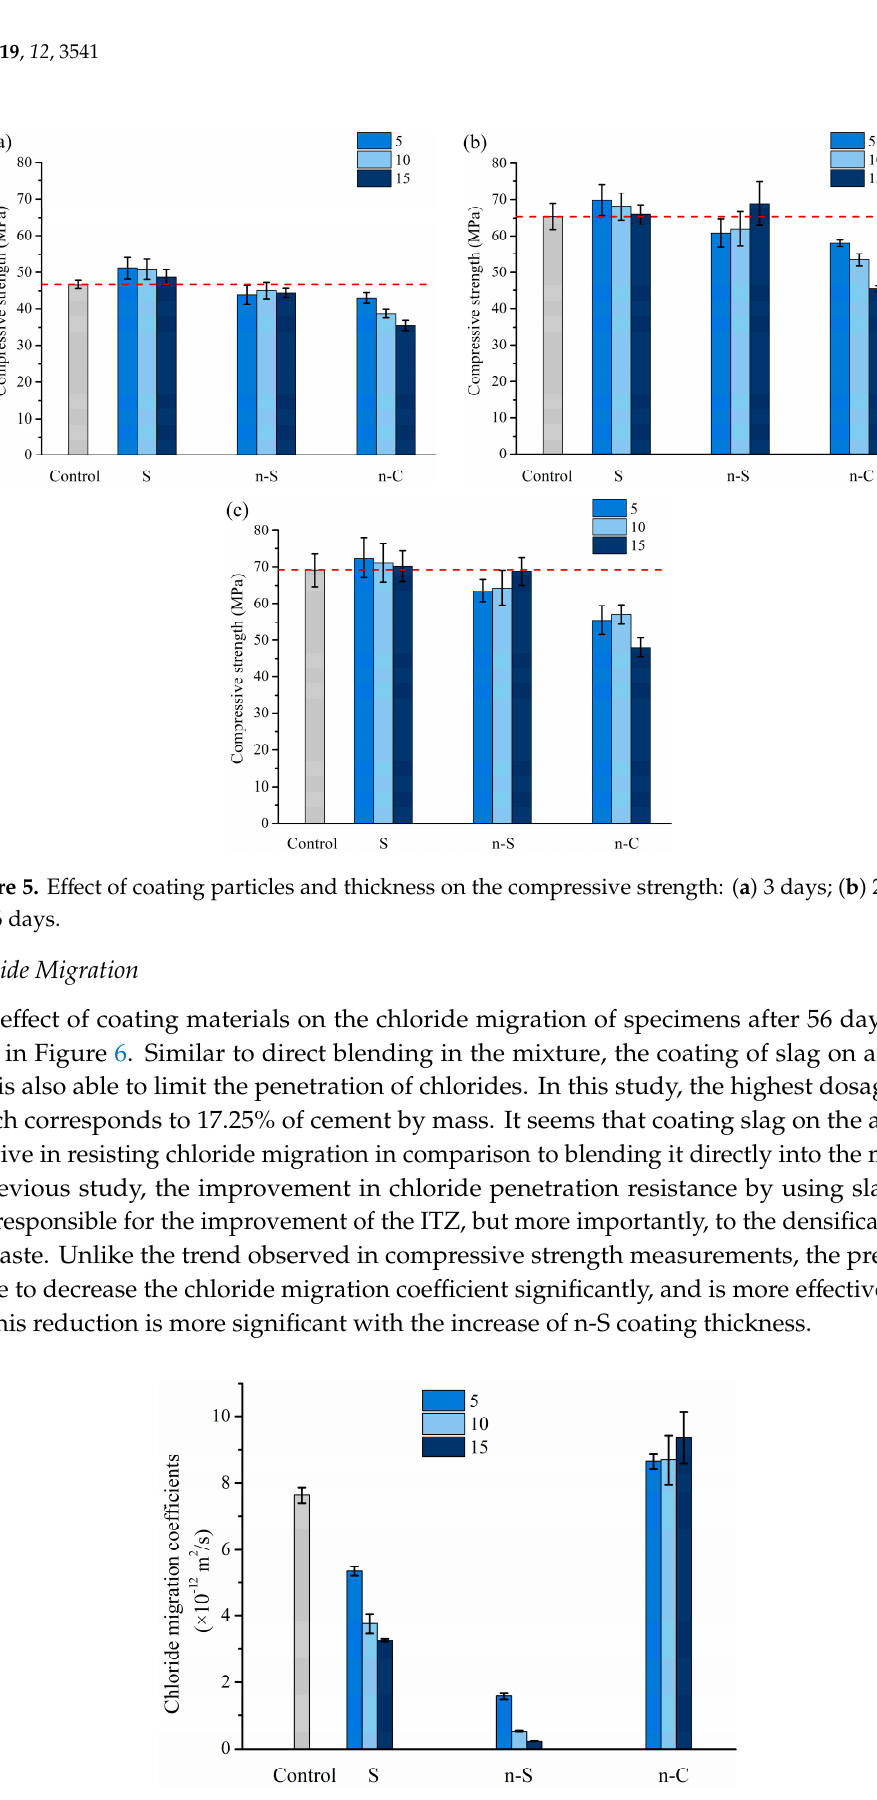
Figure 6. Effect of coating particles on the chloride migration of specimens after 56 days of curing.